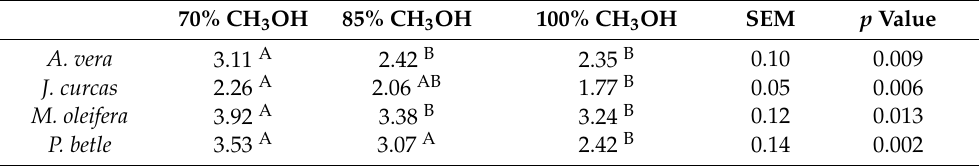
Table 1. Effects of the solvent extraction on the yield of crude extracts (g/10 g) dry